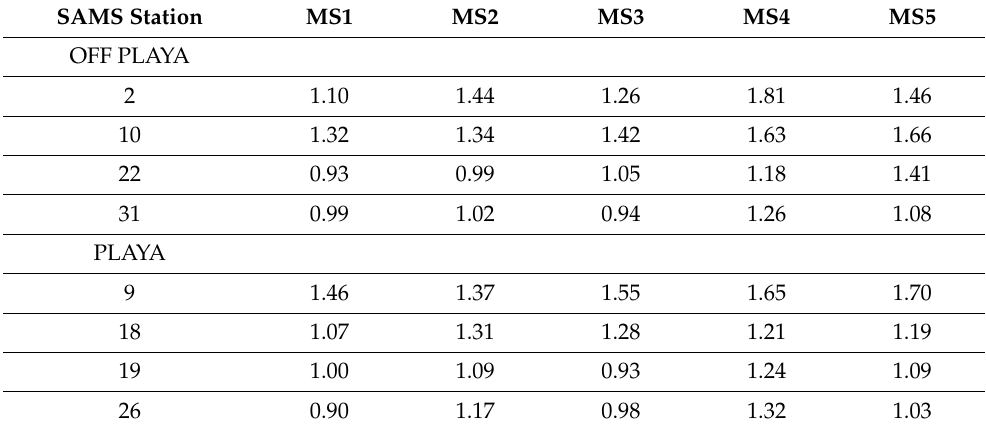
Table 5. Aggregate 10 m AGL u-wind component mean absolute error values for each model setup.